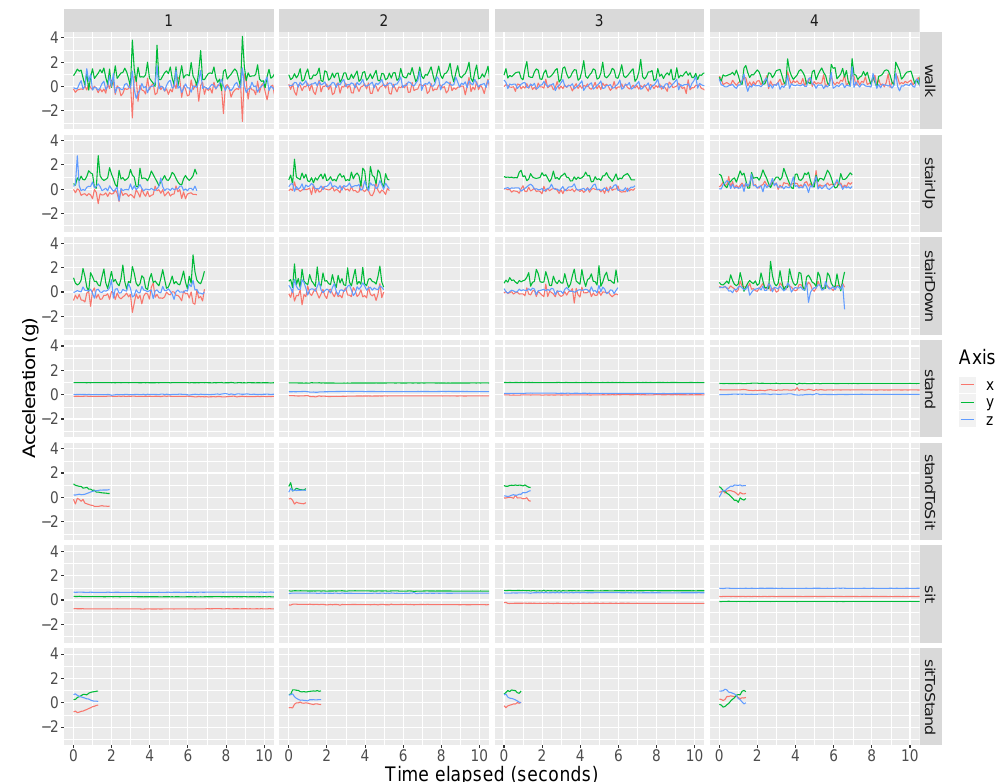
Figure 3. Training data (tri-axial) from the front pocket smartphone accelerometer. The raw tri-axial data ( x = red, y = green, z = blue) from the front pocket accelerometer is shown. See Figure 2 for